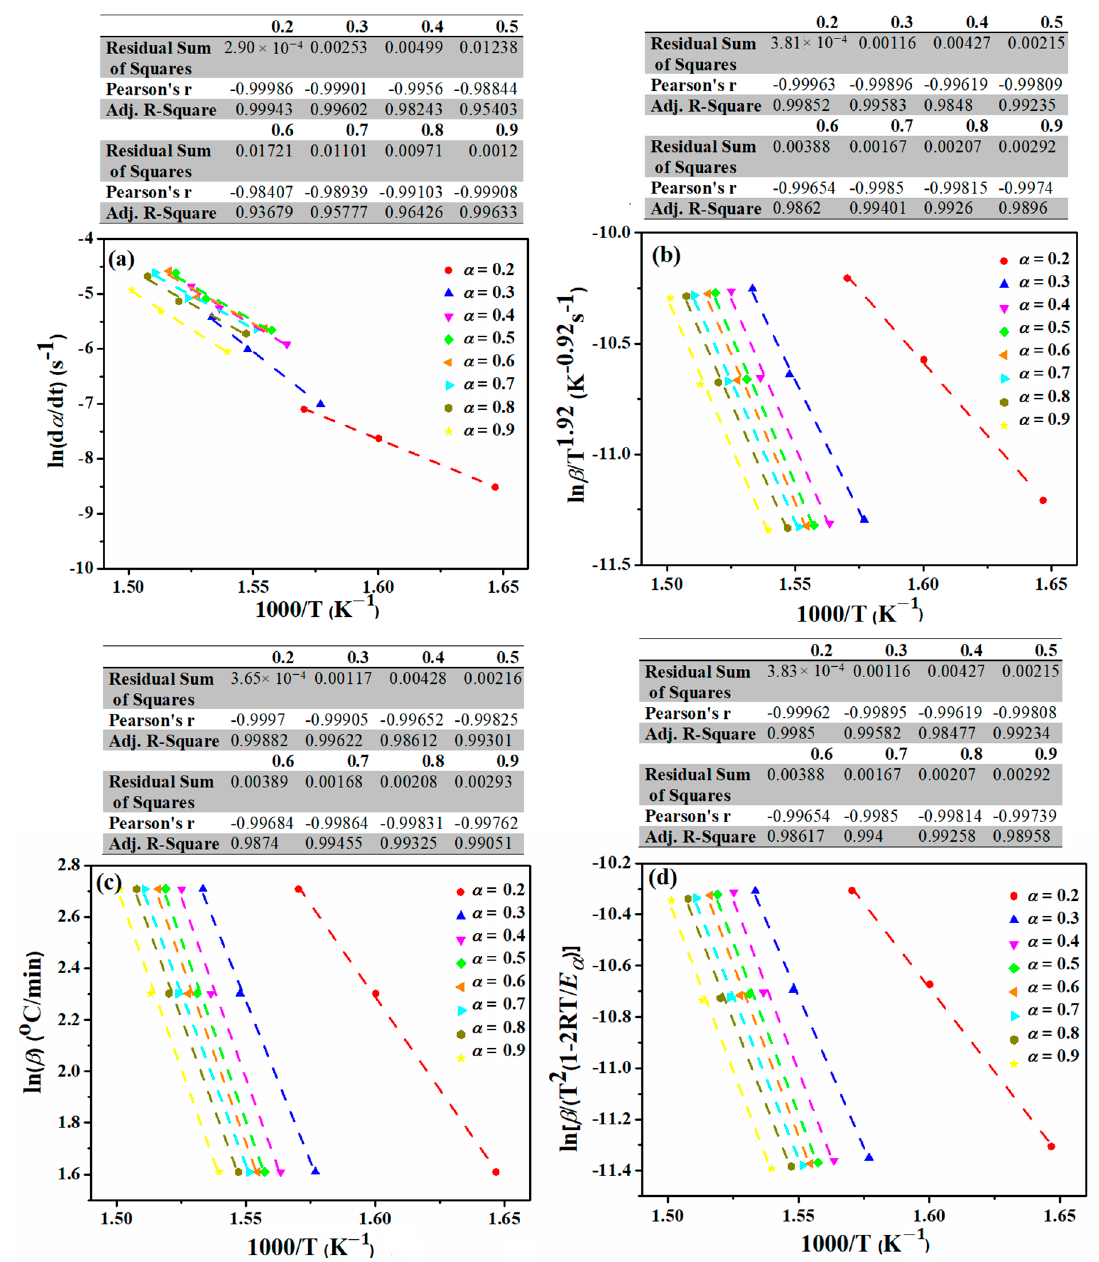
Figure 5. Typical isoconversional plots for PU/V-ZrO 2 nanocomposites ( a ) Friedman , ( b ) Kissinger– Akahira–Sunose ( KAS ) , ( c ) Ozawa–Wall–Flynn ( FWO ) and ( d ) modified Coats–Redfern (m-CR) methods.